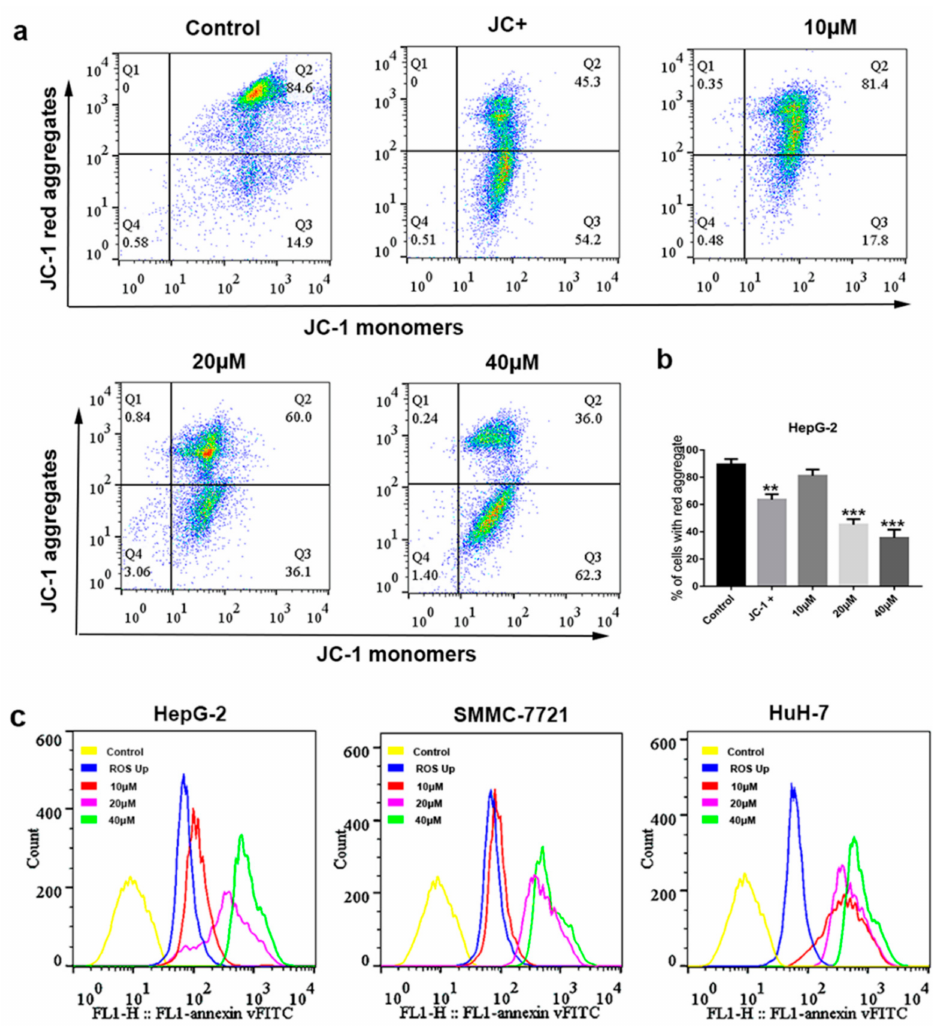
Figure 4. The loss of ∆Ψ m and ROS changes in HCC cells induced by compound 1 . ( a ) The change in ∆Ψ m in HepG-2 cells treated with various concentrations (0, 10, 20 and 40 µ M) of compound 1 for 72 h were determined by flow cytometer analysis of JC-1. The regent JC+ from the JC-1 assay kit was used as a positive control. ( b ) Representative histograms of the loss of ∆Ψ m indicated by percentage (%) of cells with red aggregates. Data are represented as mean ± SD of three independent experiments. ( c ) HepG-2, SMMC-7721, and HuH-7 cells were first incubated with various concentrations (0, 10, 20 and 40 µ M) of compound 1 for 72 h. Then, DCFH-DA (10 µ M) was loaded, and the changes